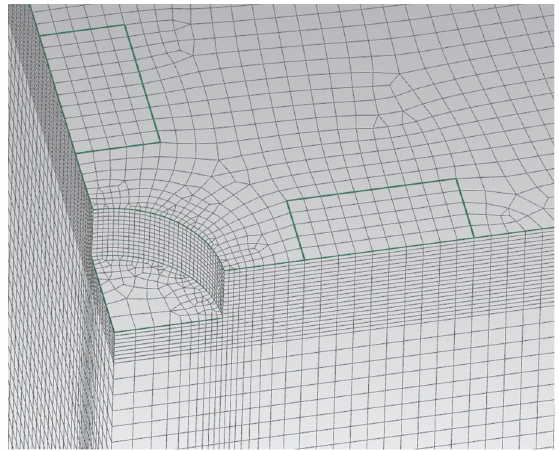
Figure 7. Finite element model with drilled hole.